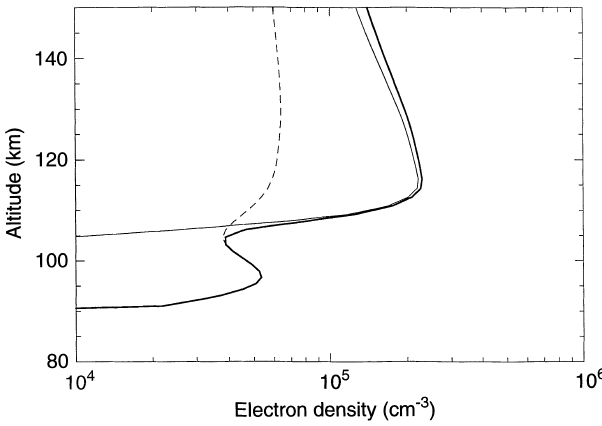
Fig. 3. The bold line is the present computation of the electron density from the coupled electron/proton transport equations, as in Fig. 1. The thin solid line is the electron density when the only source is the protons, and the dashed line takes only the electron precipitation into account.